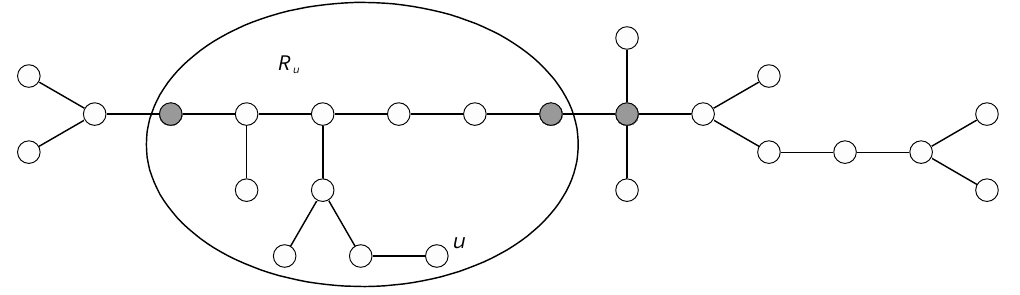
Fig. 1: An example of a partially-colored forest with six trunks, one of which is